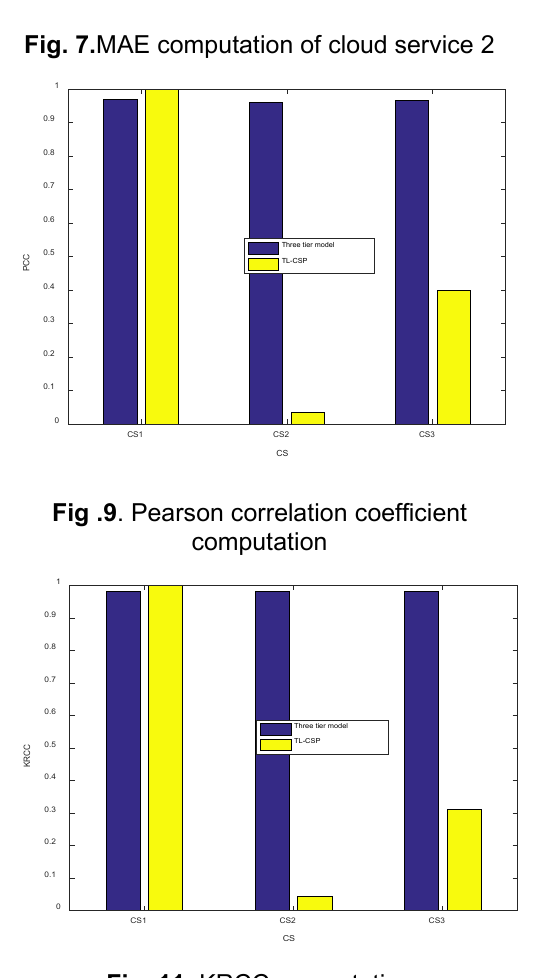
Fig.10 . Cosine similarity computation Fig .11 . KRCC